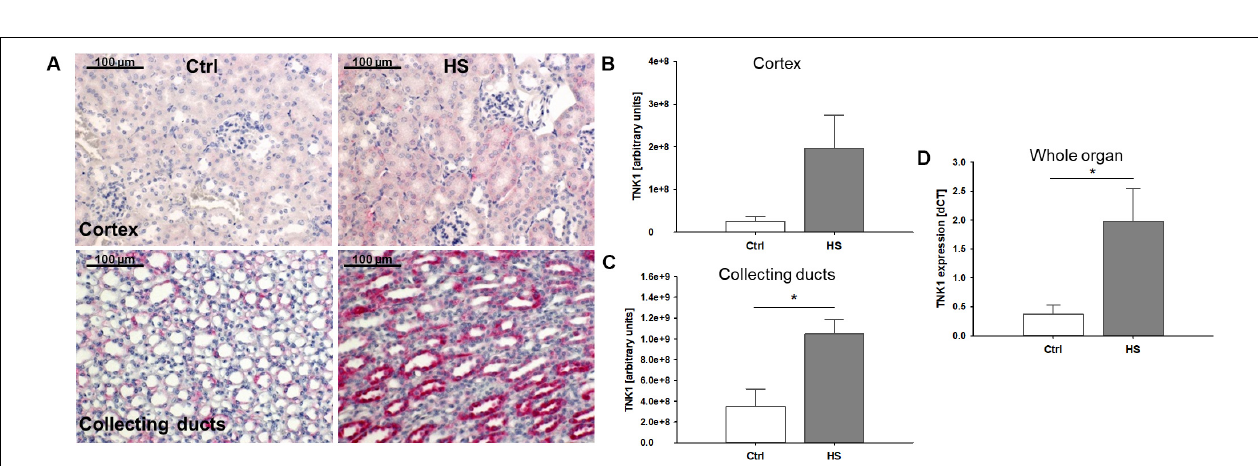
FIGURE 2 | Kidney injury and dysfunction in murine HS. (A) Mice after hemorrhage (30 mmHg, 60 min) and resuscitation (HS) demonstrated significantly increased plasma creatinine compared to healthy controls (Ctrl). Plasma kidney injury molecule 1(KIM-1, B ) and neutrophil gelatinase-associated lipocalin (NGAL) in plasma (C) and urine (D) were elevated by trend, but not significantly, in animals after HS. * p < 0.05; n = 4 ctrl, and n = 8 HS for (A–C) ; n = 3 ctrl, n = 8 HS for (D) .